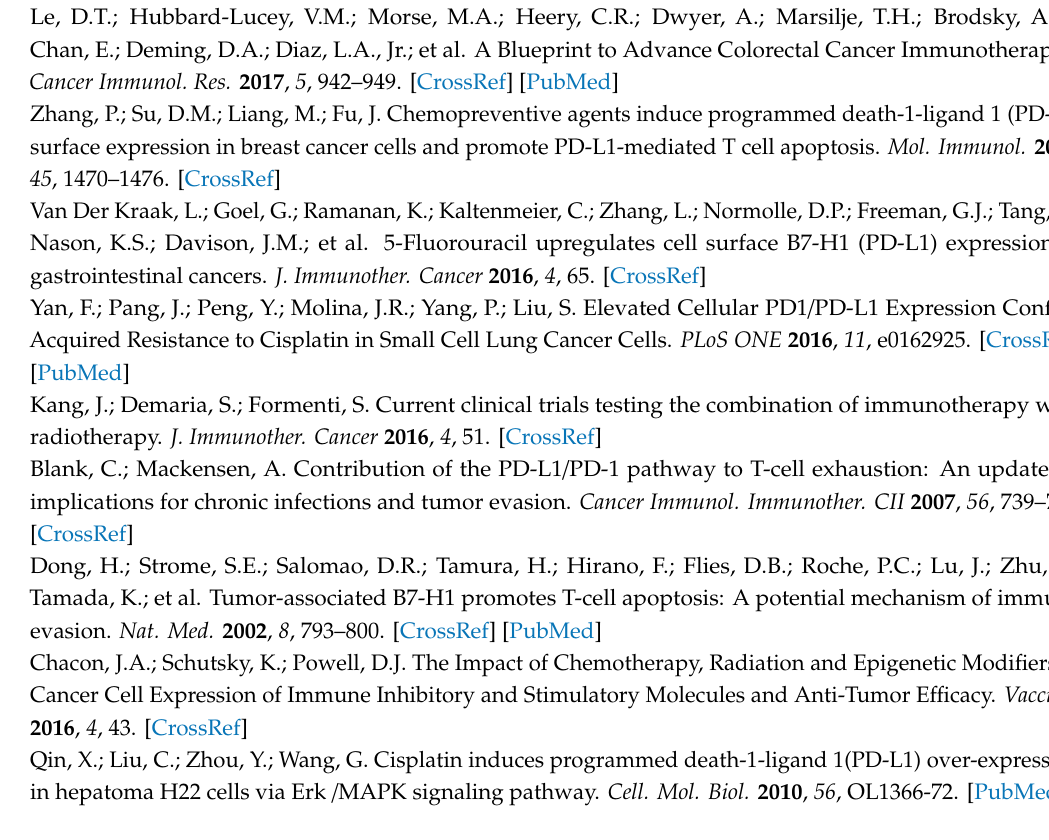
Figure S1: Expression profiles and patient survival probabilities for additional CPT-responsive cytokine genes, Figure S2: Expression profile heat map for 22 CPT-responsive cytokine genes identified using the TCGA COAD dataset, Table S1: Cytokines with overall downregulation by the treatment of SW620 cells with